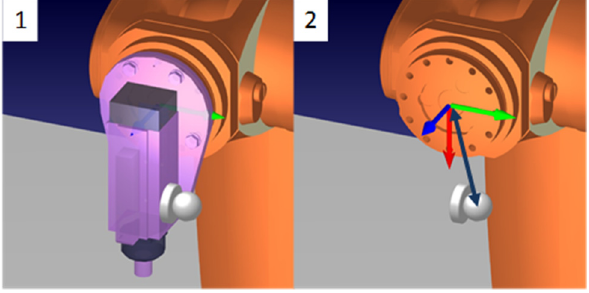
Figure 3. ( 1 ) SMR mounted on spindle; ( 2 ) SMR offset to robot flange frame.